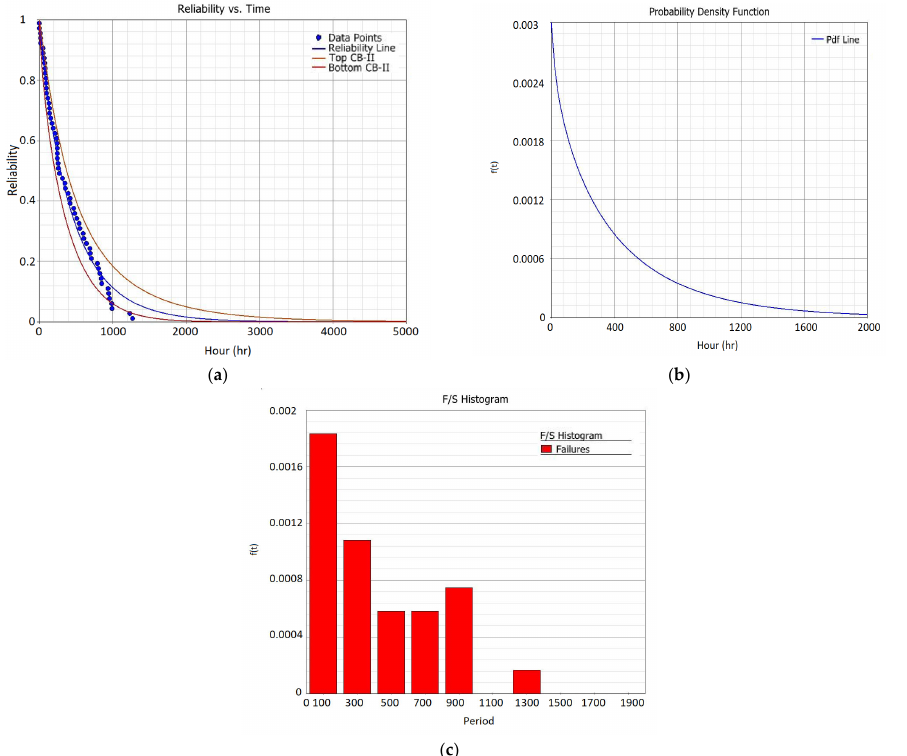
function, and the red lines representing the two-sided limits of the 90% con fi dence interval. Figures 6b–8b illustrate the probability density function f(t), which shows the distribution of data over time. Finally, Figures 6c–8c show the histogram, which rearranges the abundance of damage in quali fi ed time intervals or the consumption of residual life (FH, number of landings, cycles, etc.).